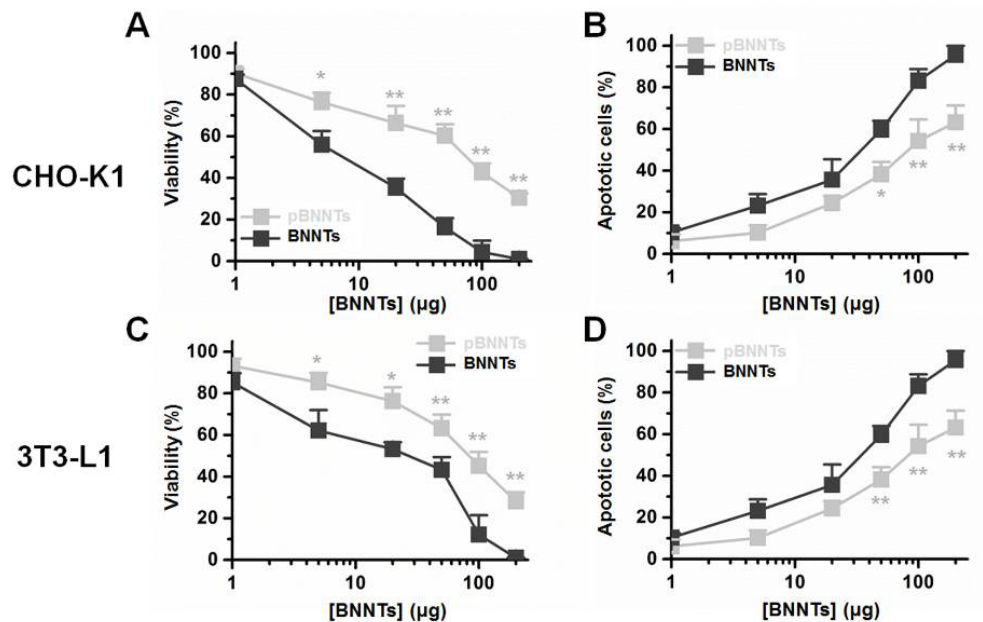
Figure 5. BNNT- and pBNNT-induced cytotoxicity in ( A ) CHO-K1 and ( C ) 3T3-L1 cells. Percentages of apoptotic ( B ) CHO-K1 and ( D ) 3T3-L1 cells after incubation with BNNTs and pBNNTs. Error bars represent the standard deviation of tee replicates. * for p < 0.05, ** for p < 0.01.